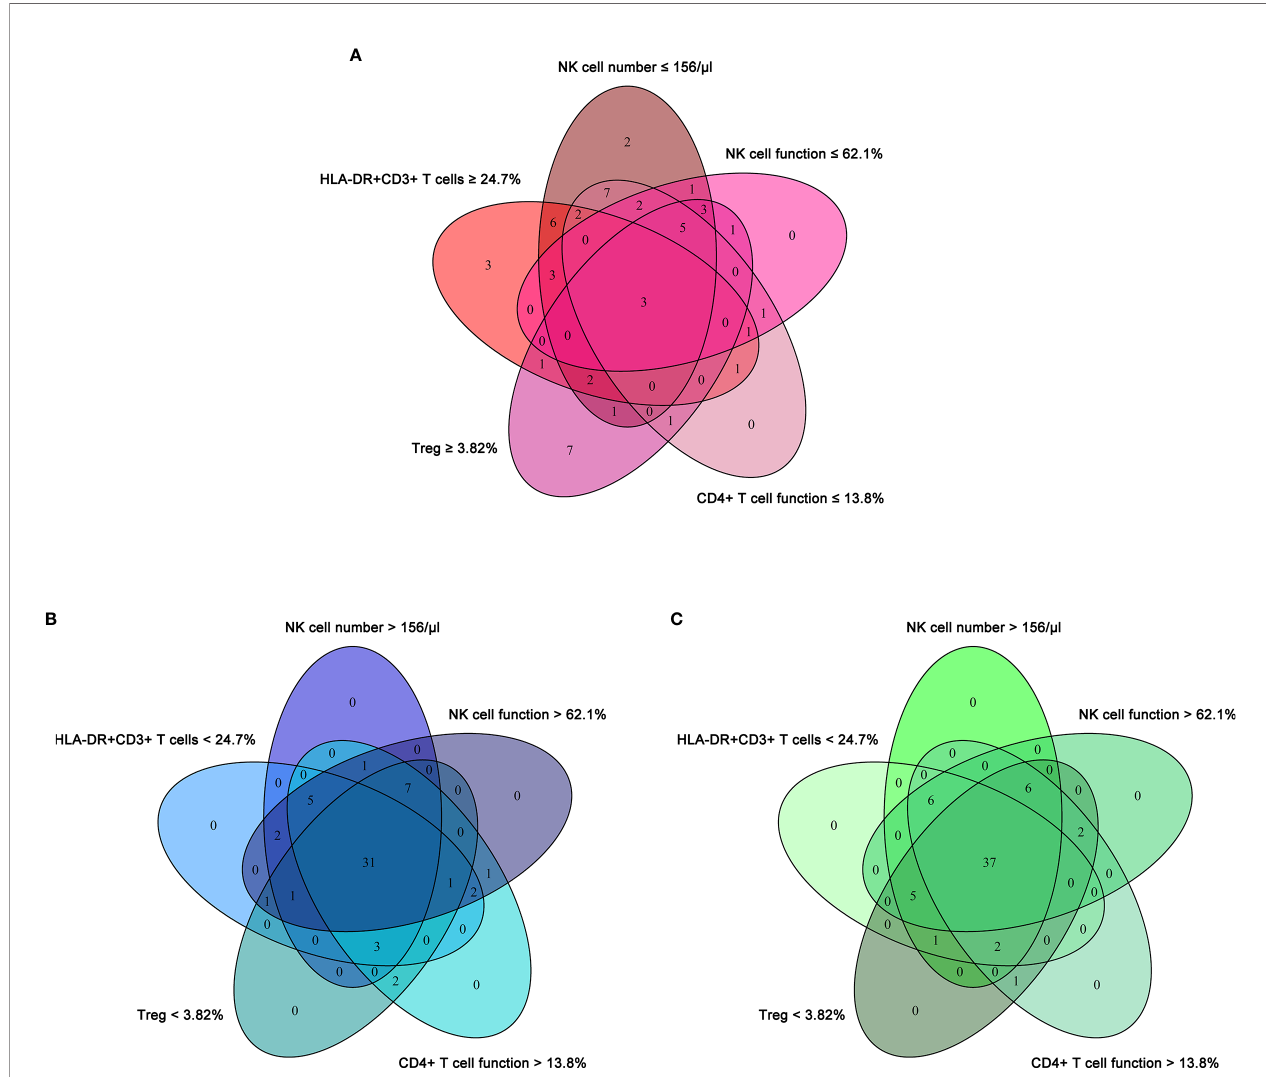
FIGURE 6 | The cross set between various immune indicators in ATB, LTBI, and HC. (A) Venn diagrams showing the overlap of NK cell number, HLA-DR + CD3 + T cells, Treg, CD4 + T cell function, and NK cell function in ATB patients. (B) Venn diagrams showing the overlap of NK cell number, HLA-DR + CD3 + T cells, Treg, CD4 + T cell function, and NK cell function in LTBI individuals. (C) Venn diagrams showing the overlap of NK cell number, HLA-DR + CD3 + T cells, Treg, CD4 + T cell function, and NK cell function in HC. ATB, active tuberculosis; LTBI, latent tuberculosis infection; HC, healthy